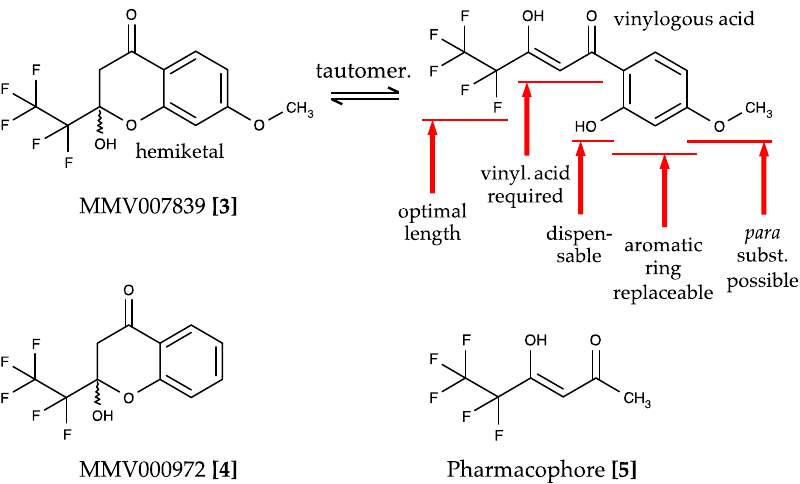
Figure 4. Screening hits of the Malaria Box and structure–activity relationships for PfFNT inhibition. MMV007839 [3] and MMV000972 [4] are neutral hemiketals that undergo tautomerization to form weak vinylogous acids in solution. Elucidation of the essential moieties and possible modification sites of the compounds identified the pharmacophore [5] .